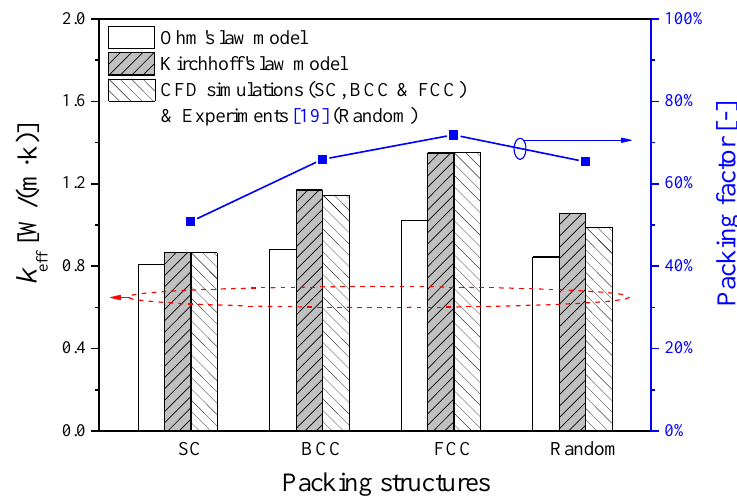
Figure 9. E ff ective thermal conductivity and packing factor of ordered and random packings Figure 9. Effective thermal conductivity and packing factor of ordered and random packings ( T = ( T = 723.15 723.15 K).